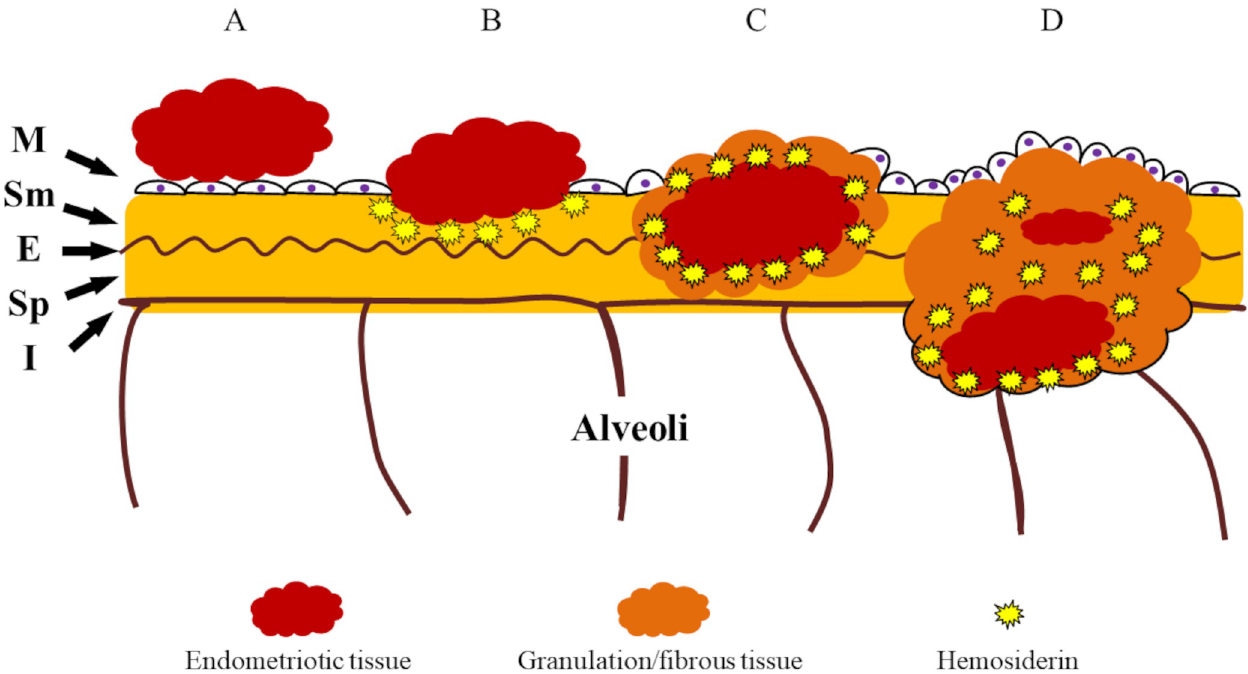
Fig 6. Schematic illustration of breaking of the visceral pleural structure in endometriosis. Endometriotic tissue migrating in the thoracic space may be located on the surface of the visceral pleura (A). Subsequently, proliferation and breakdown of the endometriotic tissue may occur during menstruation cycles on the surface of pleura as the same fashion of uterus. It may lead to bleeding, tissue repair, and inflammation of the endometriotic lesion involving the surrounding pleural tissue, suggesting stepwise breaking of the pleural structure (mesothelial, sub-mesothelial, external elastic, subpleural, and internal elastic layer)